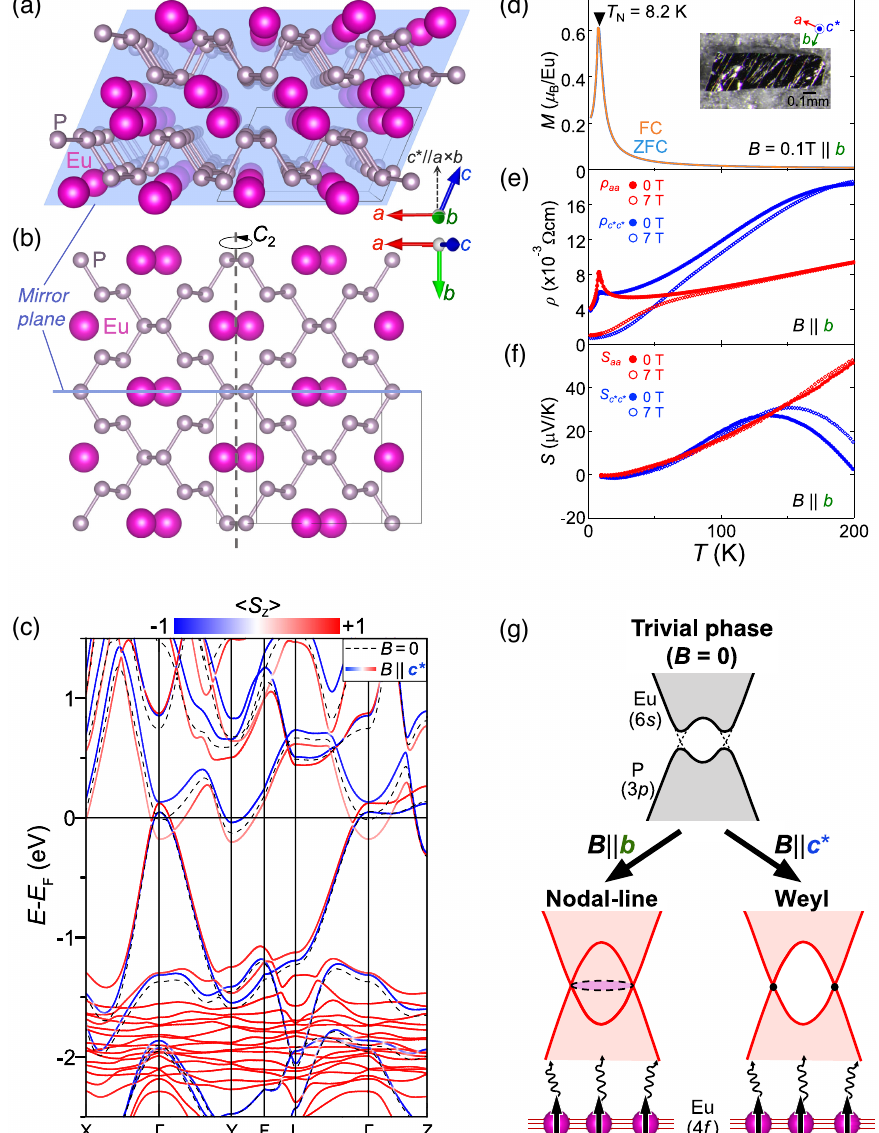
FIG. 1. Proximity-induced f - p exchange coupling in α -EuP 3 . (a) Side and (b) top views of the monoclinic crystal structure of α -EuP 3 with unique axis b . The crystal has a single mirror plane perpendicular to the unique axis. The axis c (cid:2) is depicted, along with crystalline axes a , b , c , where we define a (cid:2) , b (cid:2) , c (cid:2) as a (cid:2) k b × c , b (cid:2) k c × a ð k b Þ , and c (cid:2) k a × b , respectively. (c) Electronic structure of α -EuP 3 in the paramagnetic ( B ¼ 0 , dashed lines) and field-induced ferromagnetic (colored lines) phases. The localized 4 f bands lie approximately 1.5 eV below the Fermi level. In the FM phase calculation, Eu 2 þ f moments are fully aligned along the c (cid:2) axis, corresponding to M ¼ 7 μ = Eu, and the color of the bands represents the spin polarization. (d,e) Temperature dependence of magnetization M and B 8 . 2 K. Here, M has been measured under field resistivity ρ , respectively, through the antiferromagnetic transition temperature T N ¼ cooling (FC) and zero-field cooling (ZFC) conditions. A picture of the sample is given in the inset. (f) Temperature dependence of the Seebeck coefficient S down to 10 K. (g) Schematic picture of the band topology engineering in α -EuP 3 . Nodal-line semimetal ( B k b ) and Weyl semimetal ( B k c (cid:2) ) phases are switched by the direction of B , and the nontrivial band crossings can be tuned to the Fermi level via proximity-induced f - p exchange